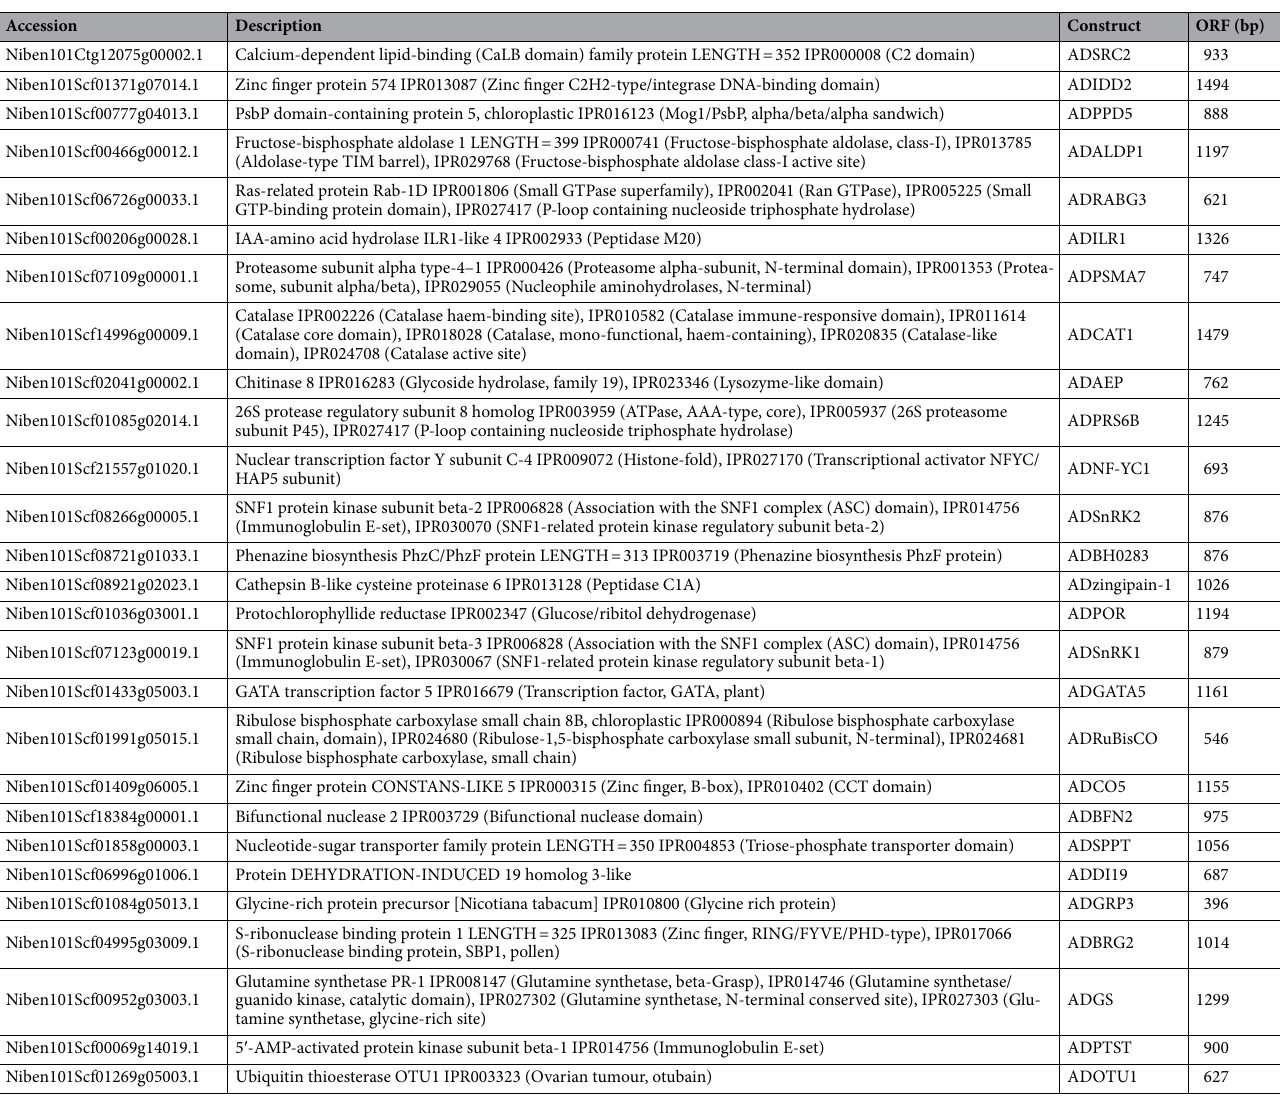
Table 1. The candidate proteins used for yeast two-hybrid